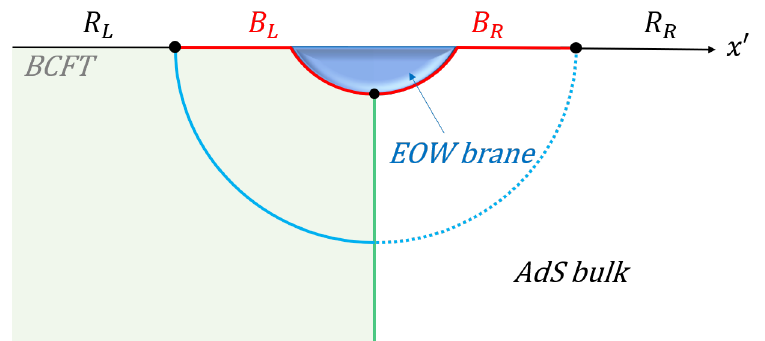
Figure 16. The connected phase viewed along z -axis. A time slice of black hole region is divided into B L and B R . The extremal surface of the whole black hole is represented by the blue curve. The entanglement wedge of the left system R L ∪ B L is the green shaded region, which is separated from the right part of the system by an extremal surface (green line).